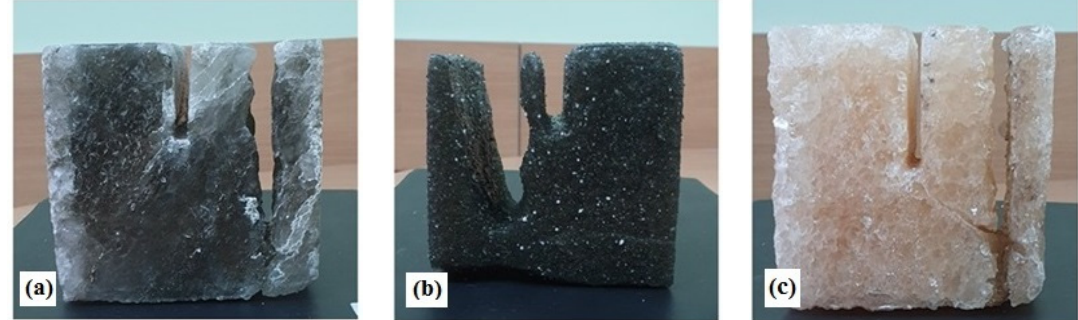
Figure 4. Salt rock samples after with niches cut by means of high-pressure water jets: (a) “green salt”; (b) “spiza” (bronze) salt; (c) “pink salt”. (The shallower niches were cut mechanically). Kłodawa is a salt dome of Zechstein (upper Permian) salt formation in Central Poland. The geographical location and the simplified geological cross-section of the dome is shown in Figure 5a. Three samples: R1, R2, R3 represent the PZ4 Youngest Halite litostratigraphic level of the PZ4 cyclotheme of Zechstein (Figure 5b). In Kłodawa mine salts from this level are called pink salts, because of the pink and orange colors. Pink salts from Kłodawa dome are generally pure rock salt, which consists of about 97% of the mineral halite and a small amount of impurities, mainly anhydrite. The samples R1 and R2 are typical pink salt. The R3 sample represents anhydrite with halite, which occurs as interlayers, bands, and irregular accumulations within the Youngest Halite complex.